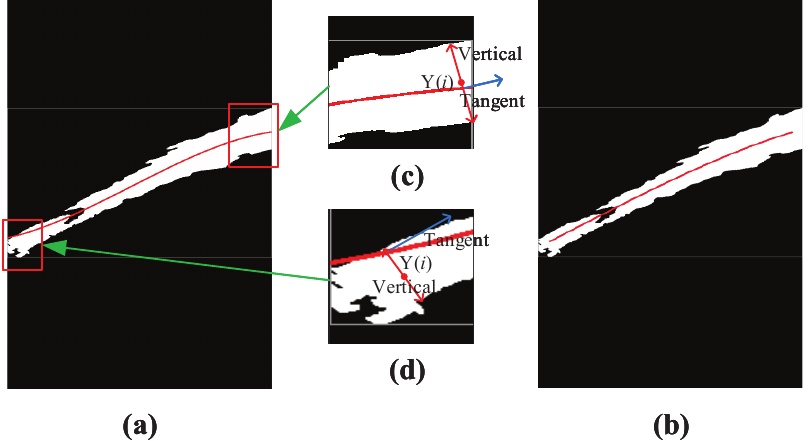
Figure 6. Example of radial centroid method results for binarized trajectory image. ( a ) binarized trajectory image; ( b ) trajectory curve; ( c ) calculation result of radial centroid method at the destination position of jet trajectory; ( d ) calculation result of radial centroid method at the origin position of jet